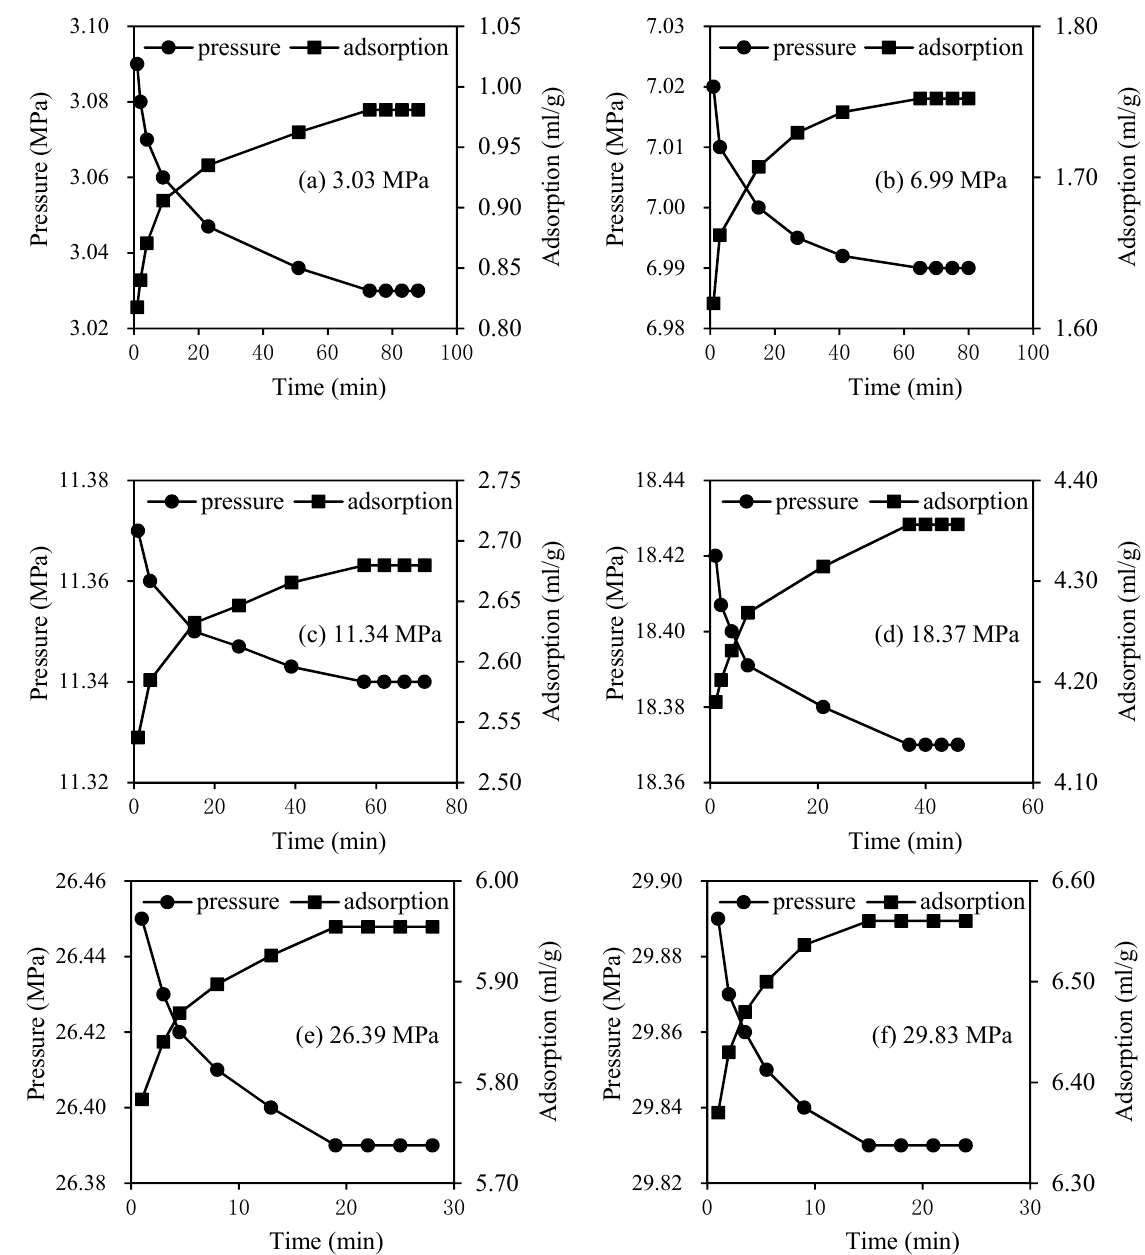
Figure 2. Methane adsorption dynamic on shale sample at seven pressure steps and 30 °C